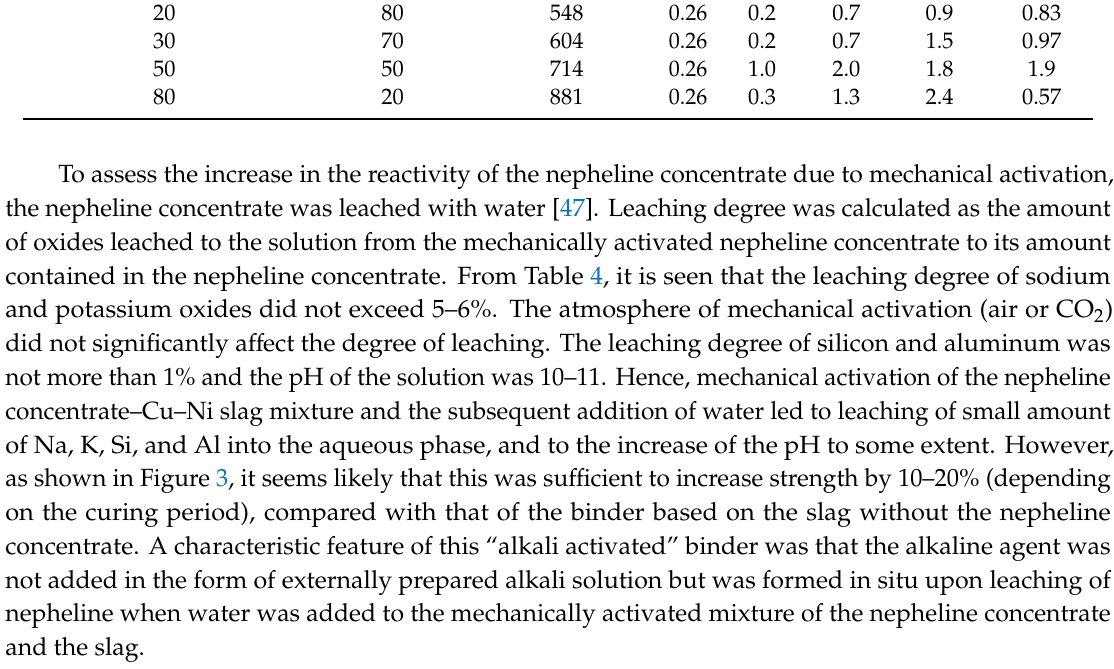
Table 3. The compressive strength (R) of the NC–Cu–Ni slag–water binder. MA was carried out in air for 270 s (w / s: water to solid ratio; S sp : the specific surface area of the NC–Cu–Ni slag mixture). Composition, wt. % Nepheline Concentrate